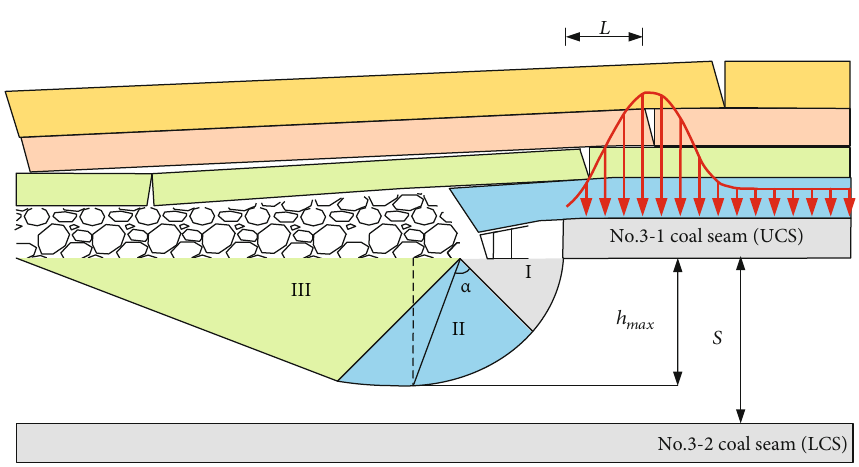
Figure 3: Schematic diagram of the failure depth of No.3-1 coal seam fl